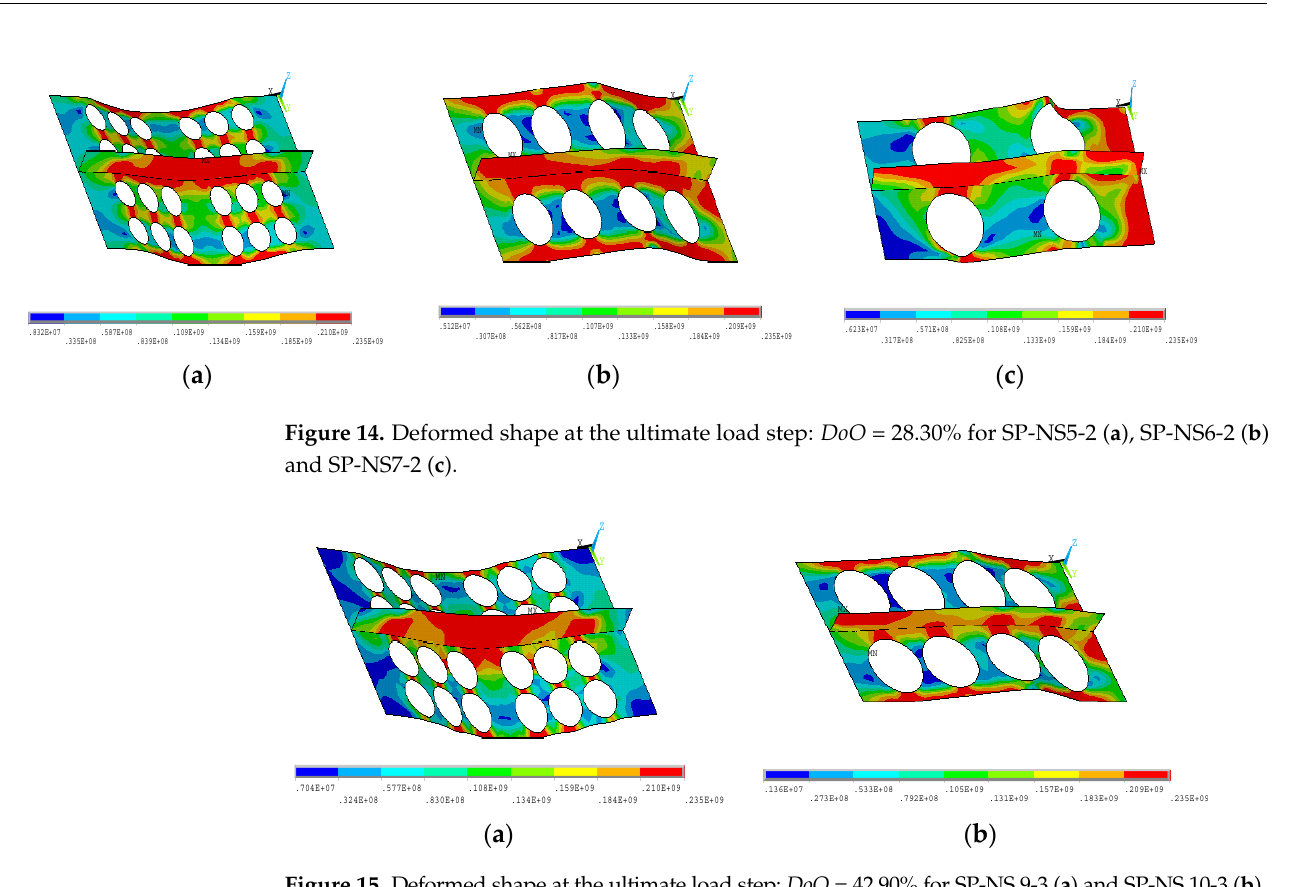
Figure 15. Deformed shape at the ultimate load step: DoO = 42.90% for SP-NS 9-3 ( a ) and SP-NS 10-3 ( b ).